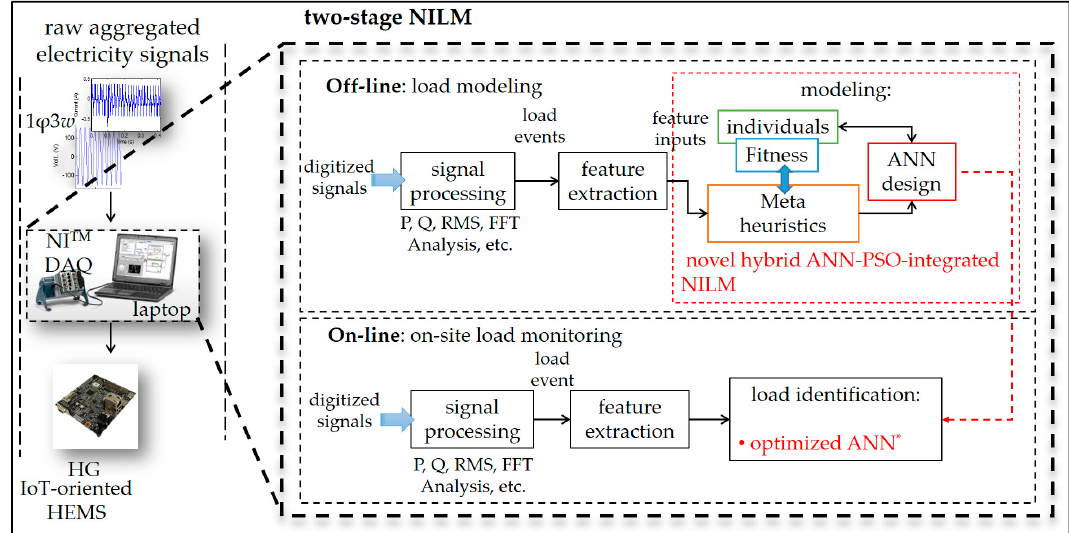
Figure 4. Illustration of the two-stage NILM used to automatically and meta-heuristically design ANN. This NILM is trained on-site and off-line for load modeling, and is subsequently executed on-line for on-site load monitoring. Features used and identified by the proposed novel hybrid ANN-PSO-integrated NILM can be P, Q, Root-Mean-Square (RMS) values, and/or Fast Fourier Transform (FFT).